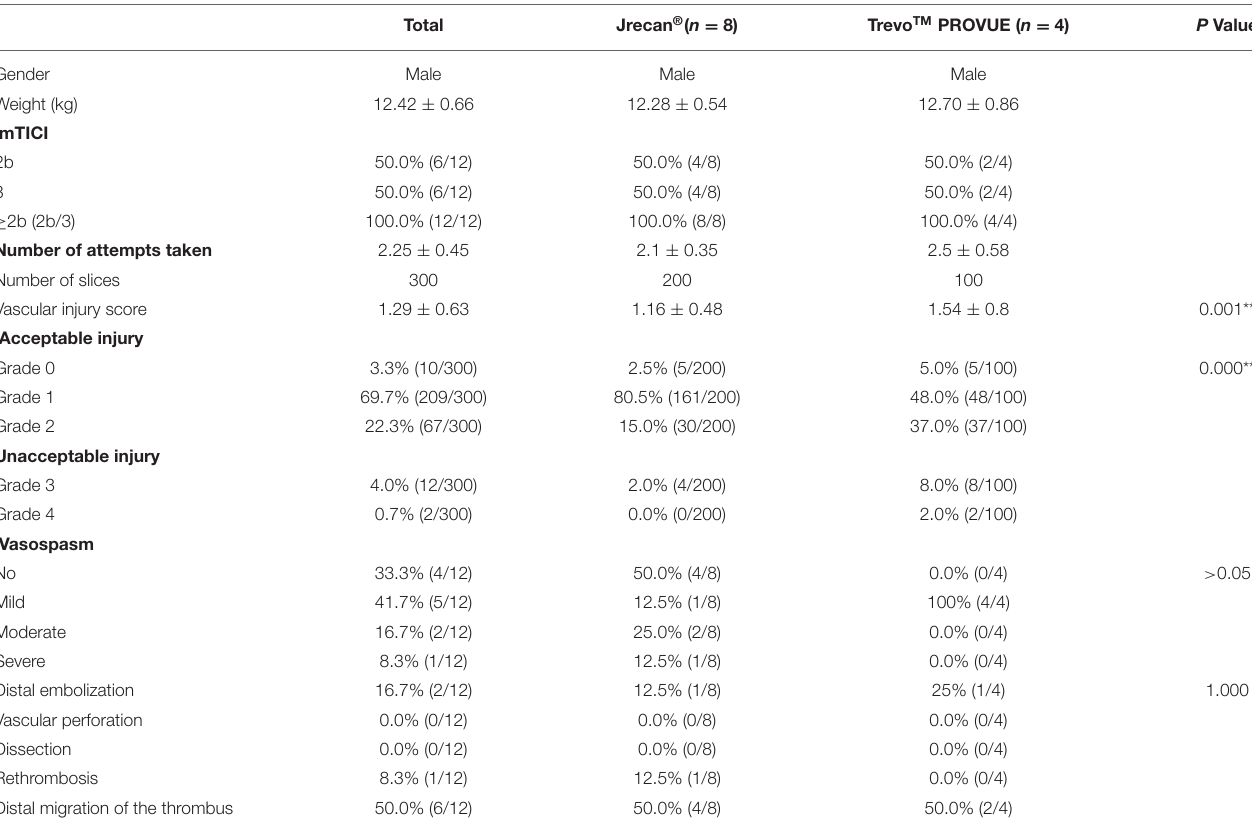
TABLE 1 | Comparison of the safety and efficiency between Jrecan ® and Trevo TM